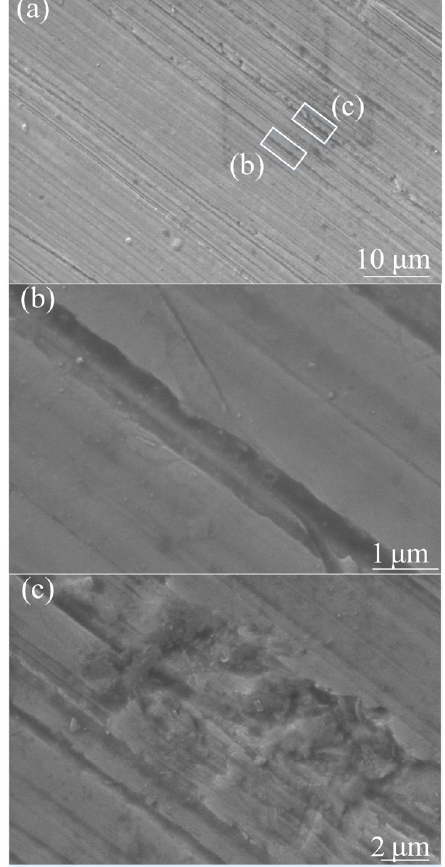
Fig. 11 SEM pictures of (a) blunt areas, (b) smooth grooves, and (c) irregular grooves.